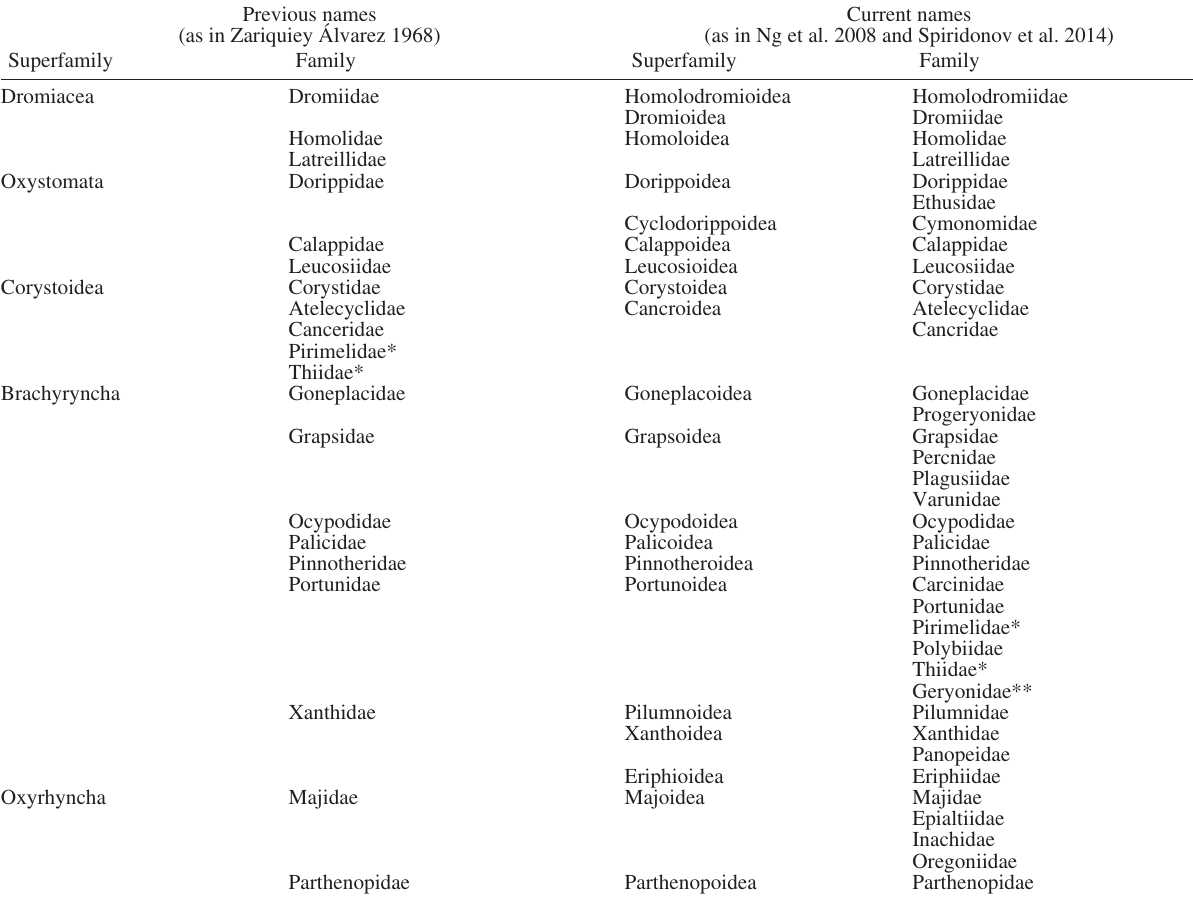
Table 3. – Previous and current names (and family composition) of the superfamilies of brachyuran crabs present in the Iberian Peninsula, listed by systematic